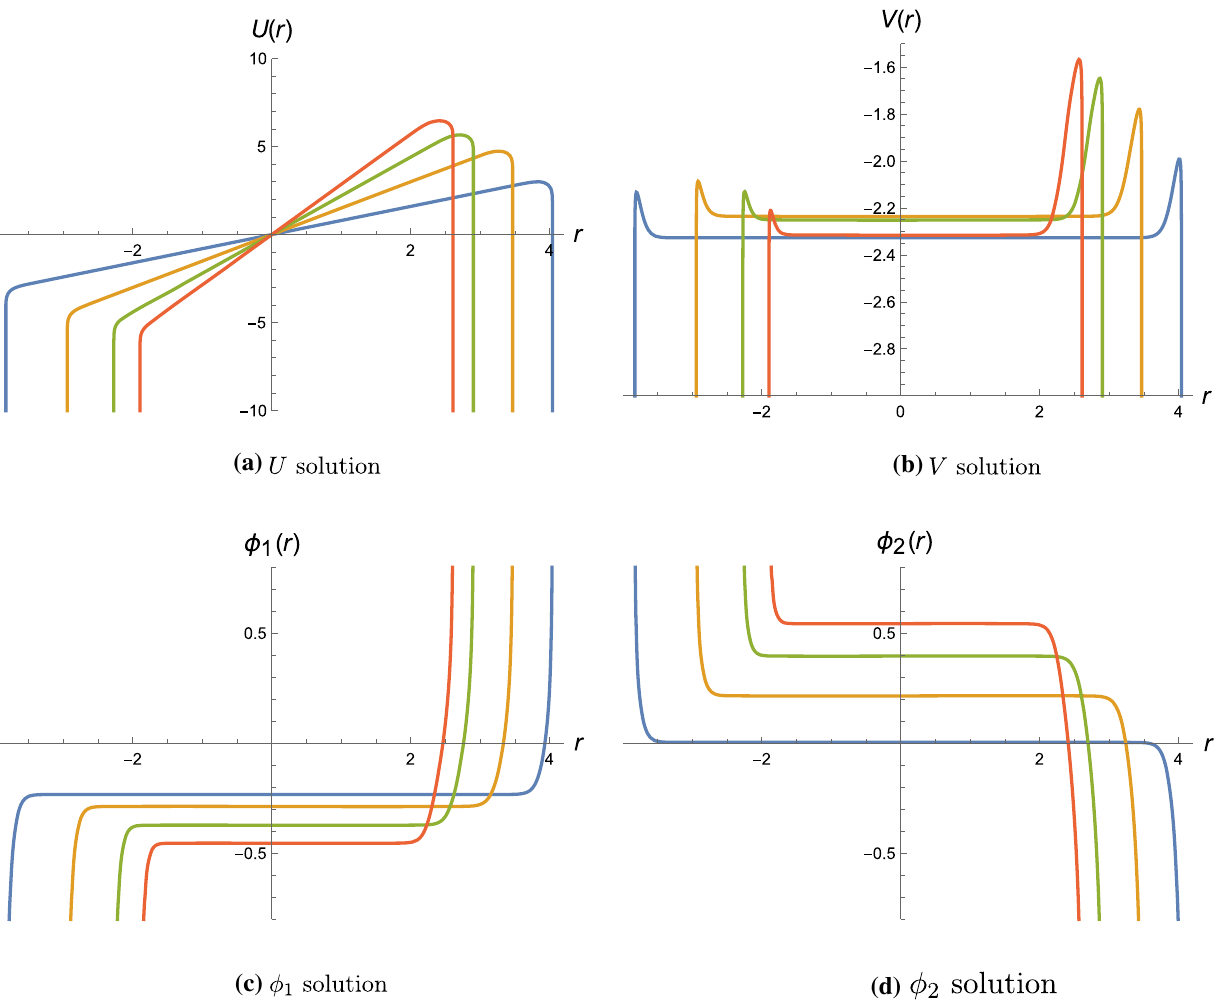
Fig. 5 RG flows between AdS 5 × S 2 fixed points and curved domain walls for SO ( 2 ) × SO ( 2 ) twist in SO ( 3 , 2 ) gauge group. The blue, orange, green and red curves refer to p 2 = − 1